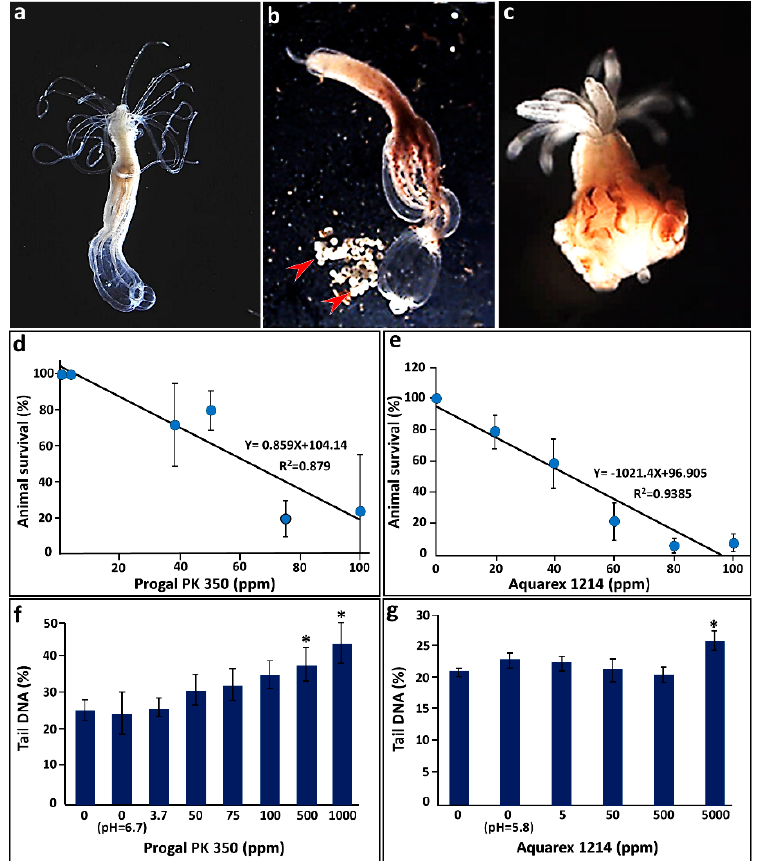
Figure 2. ( a ) N. vectensis normal morphology. ( b ) N. vectensis phenotype following exposure to